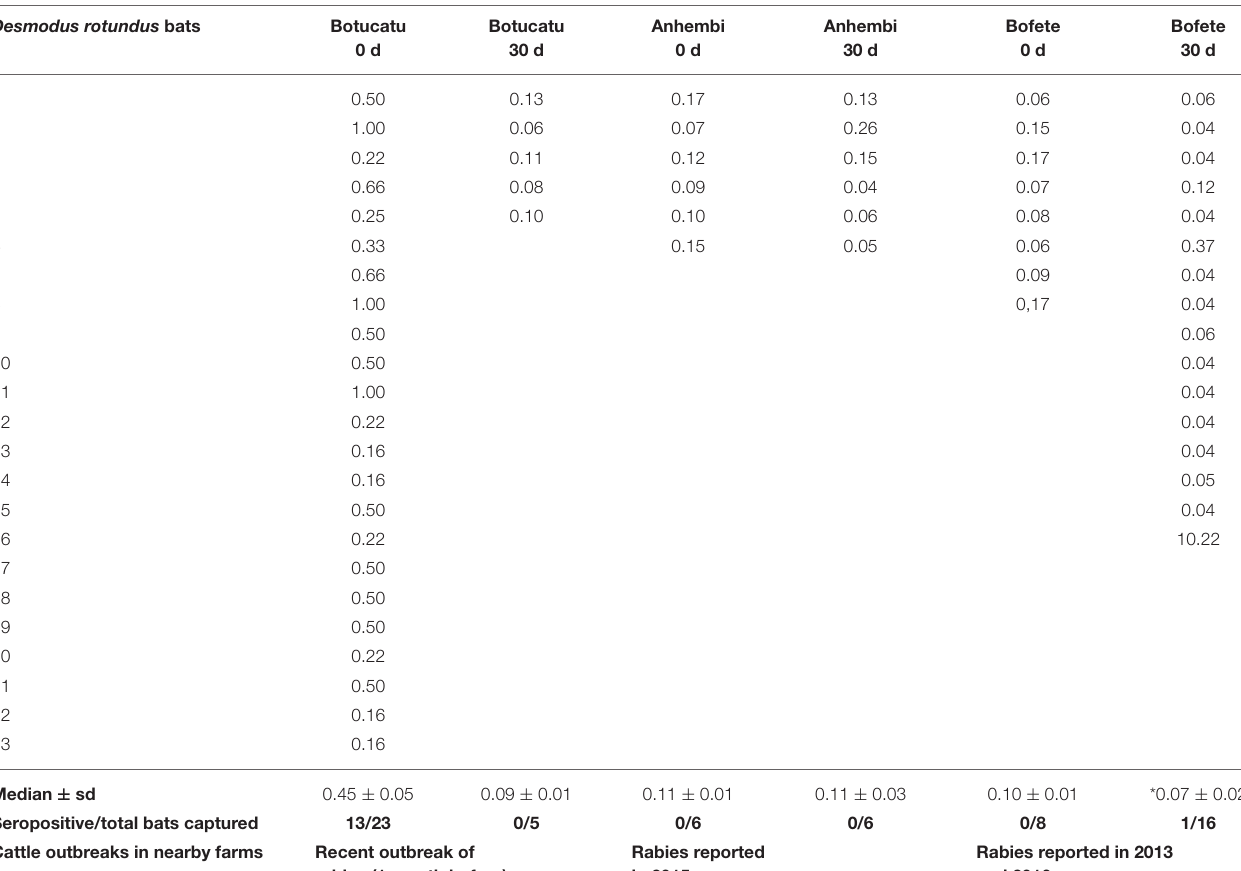
TABLE 1 | Antirabies neutralizing antibodies titers in Desmodus rotundus bats captured, from December 2015 to june 2016, in geographic areas with different epidemiological situation for rabies among livestock. Desmodus rotundus